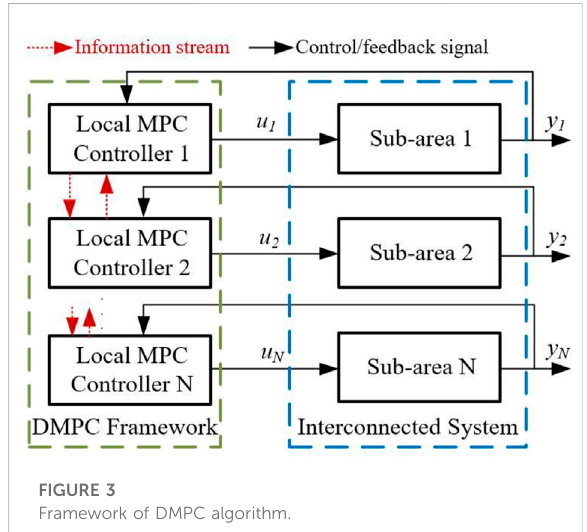
FIGURE 3 Framework of DMPC